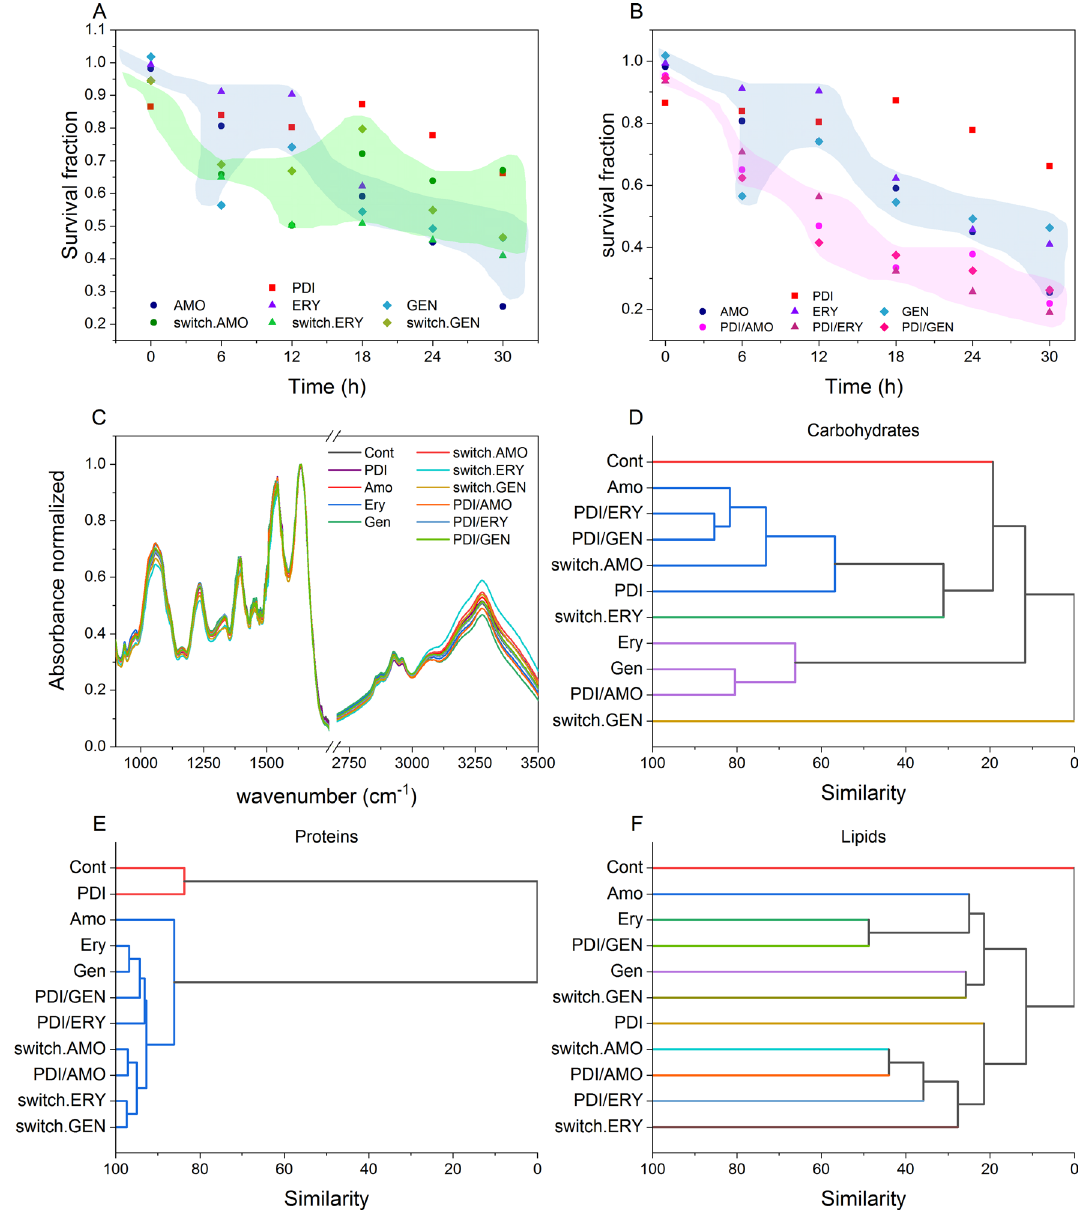
Figure 4. Treatment cycle. Red: PDI with 10 μM of curcumin and 10 J/cm 2 and Blue: antibiotic group. Normalizations performed for untreated bacteria. ( A ) Combined treatment switched every 6 h, starting with PDI (switch.ANTB). ( B ) Combined treatment—concomitant PDI and ANTB every 6 h (PDI/ANTB). ( C ) FTIR absorbance spectrum of surviving bacteria after 12 h of treatment cycle of PDI, AMO, ERY, and GEN monotherapies; sequentially combined treatments every 6 h (PDI/ANTB), and switching PDI and antibiotics every 6 h (switch.ANTB). Hierarchical Cluster Analysis of the 2nd derivative of the FTIR absorption spectrum of regions ( D ) 900–1200 cm −1 , corresponding to carbohydrates, ( E ) 1500–1800 cm −1 , corresponding to protein, and ( F ) 2800–3100 cm −1 , corresponding to fatty acids. Colors of the dendrogram indicate clustering of similarity greater than 50%. A statistically significant difference was considered p <